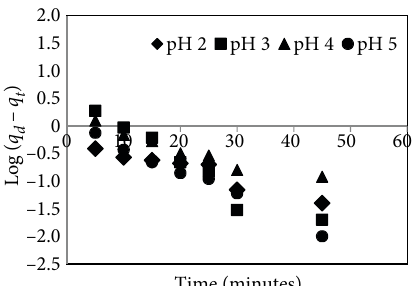
Fig. 8. Graphs of pseudo first – order kinetic models for